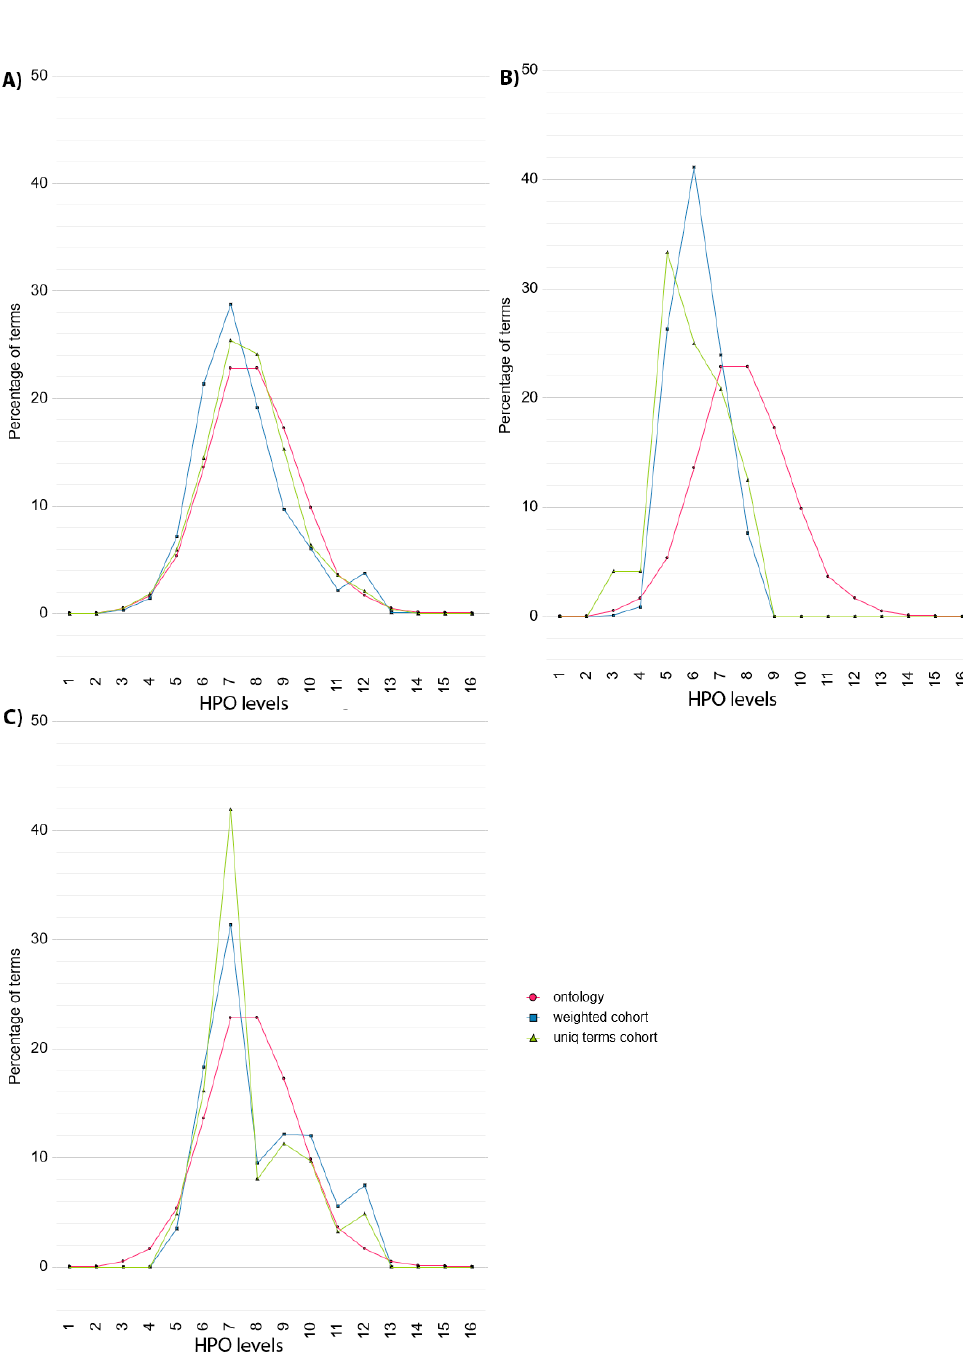
Figure 3. HPO term percentage distribution plots for ( A ) DECIPHER, ( B ) ID/MCA and ( C ) PMM2- CDG datasets. Green curves represent the percentage of unique HPO terms used to describe the cohort, blue curves take into account the frequency of each term and pink curves show the percentage of terms included in the HPO at each level. Table 5. Dataset specificity Index for each cohort. Results for the datasets following filtering to remove patients with less than three assigned HPO terms are indicated with >